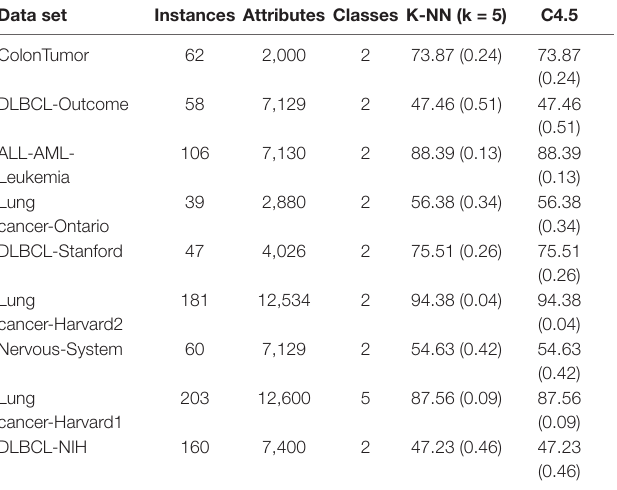
TABLE 7 | The format of datasets. TABLE 8 | The running result for four